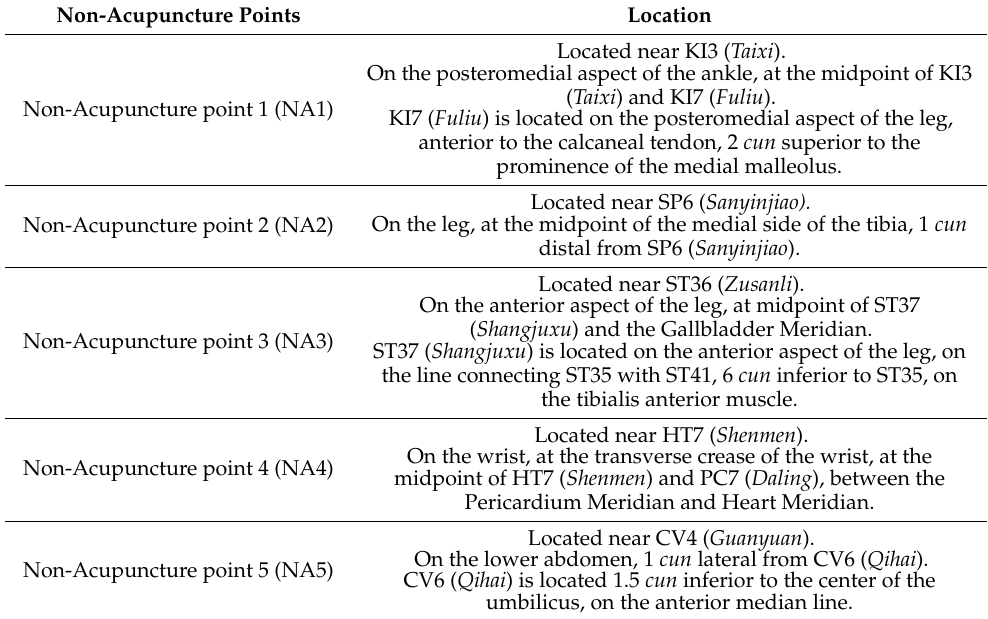
Table A2. Non-Acupuncture points * selected for this study.